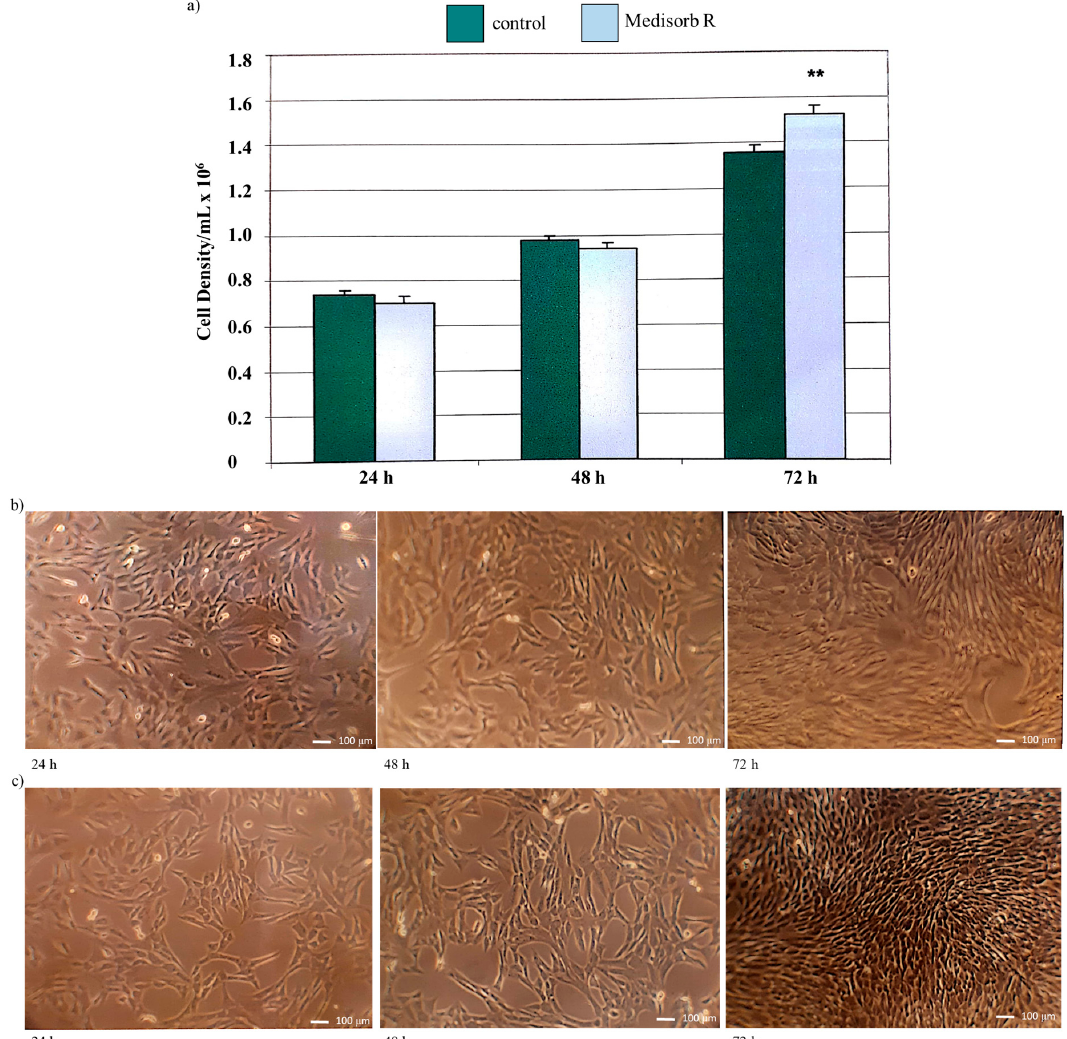
Figure 7. ( a ) Proliferation of 3T3Balb/C mice fibroblasts after 24, 48, and 72 h the presence of Medisorb R extract. Microscopic pictures of T3TBalb/C mice fibroblasts cells: ( b ) control culture ( c ) culture with R extract.